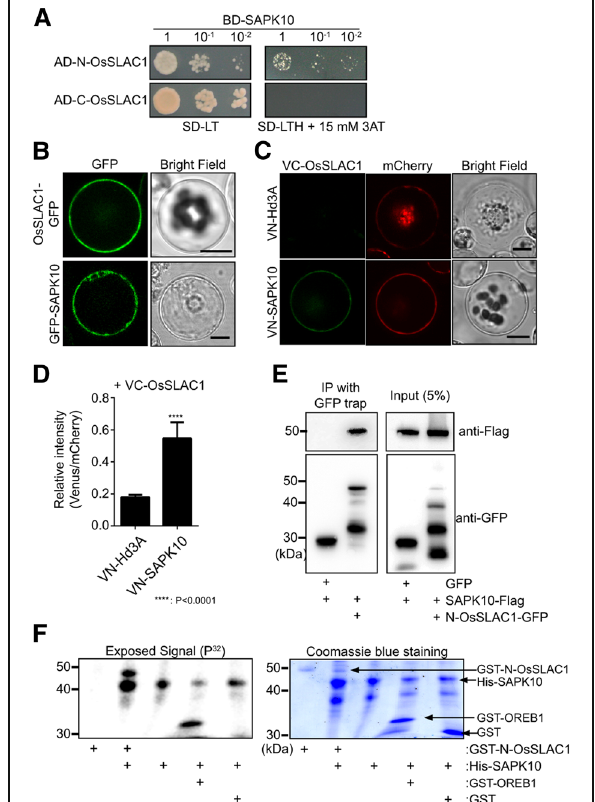
Fig. 3 SAPK10 physically interacts with OsSLAC1 and phosphorylates the N-terminal region of OsSLAC1 in vitro. a Yeast two hybridization assays. SAPK10 was used as bait (BD-SAPK), and the N-terminal region and C-terminal regions of OsSLAC1 were used as prey (AD-N-OsSLAC2 and AD-C-OsSLAC1). b Subcellular localization of SAPK10-GFP in rice protoplasts. c BiFC analyses of VN-SAPK10 and OsSLAC1-VC using rice protoplasts. ER-mCherry was used as an internal control. VN-Hd3A was used as a negative control. Scale bars are 10 μ m. d The relative BiFC signal intensities depict the average±SD of over 20 cells emitting the fluorescence signals. The value was calculated as Venus signal/mCherry signal. e Co-IP analysis using GFP-N-terminal SLAC1 and SAPK10-Flag coexpressed in rice protoplasts. These experiments were repeated three times and a representative result was presented. f In vitro kinase assay for His-SAPK10 activity with GST-N-OsSLAC1. The 32 P radioactivity was detected using a phosphor image analyzer (upper panel) and polyacrylamide gel was stained using Coomassie brilliant blue R250 (lower panel). GST-N-terminal region OREB1 (GST-N-OREB1) was used as a We further investigated the interaction and subcellular localization of this complex using a bimolecular fluores- cence complementation (BiFC) assay. A yellow fluores- cence signal was observed on the plasma membrane when VC-OsSLAC1 and VN-SAPK10 were co-expressed in rice protoplasts but not in the negative control (VN-Hd3A and VC-OsSLAC1). The fluorescence values of VN-SAPK10 and VC-SLAC1 were three times higher than VN-Hd3A and VC-SLAC1 (Fig. 3c and